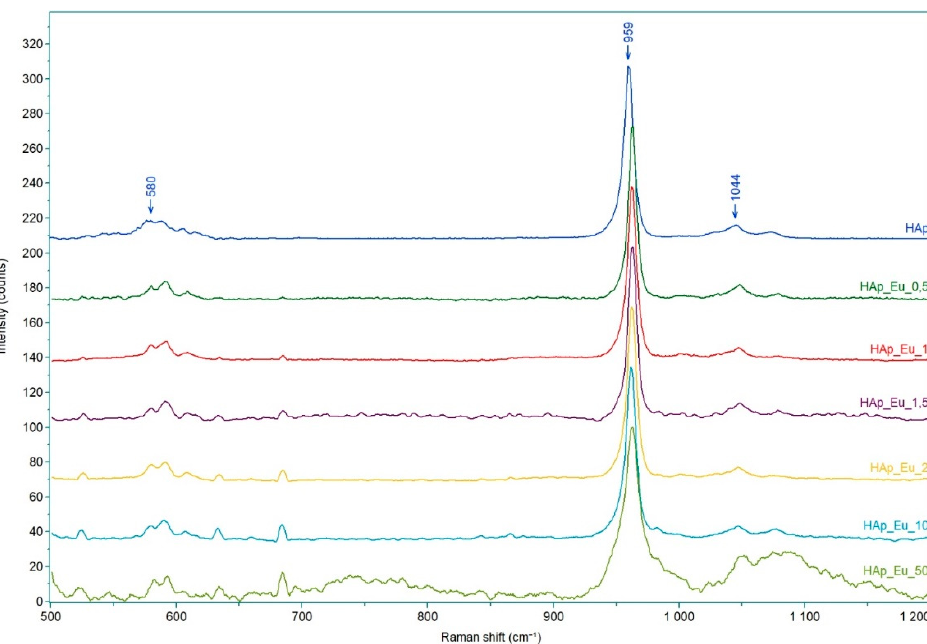
( B ) Figure 8. ( A ) UV-Vis absorption spectra of Eu X HAp at different Eu-concentrations ( B ) Room- temperature photoluminescence spectra of Eu X HAp at different Eu-concentrations. 200